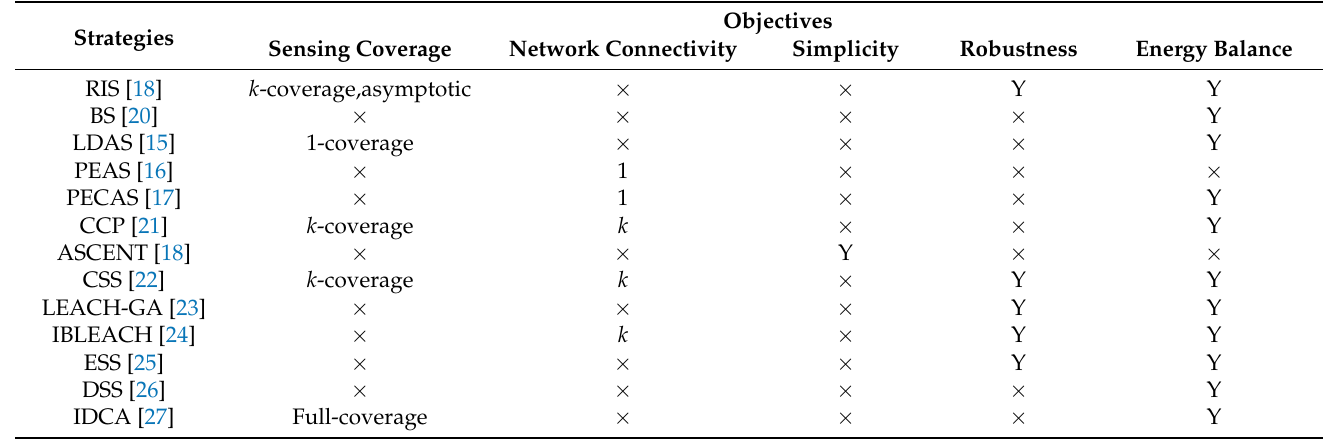
Table 2. The studies’ classifications according to their